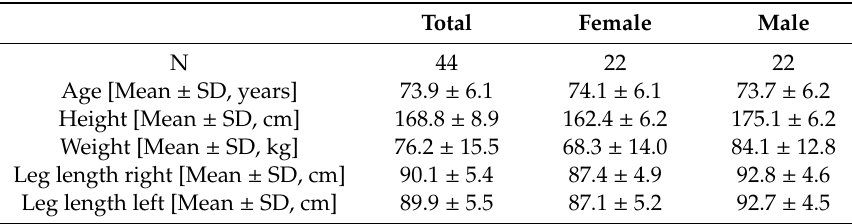
Table 1. Socio-demographic data of